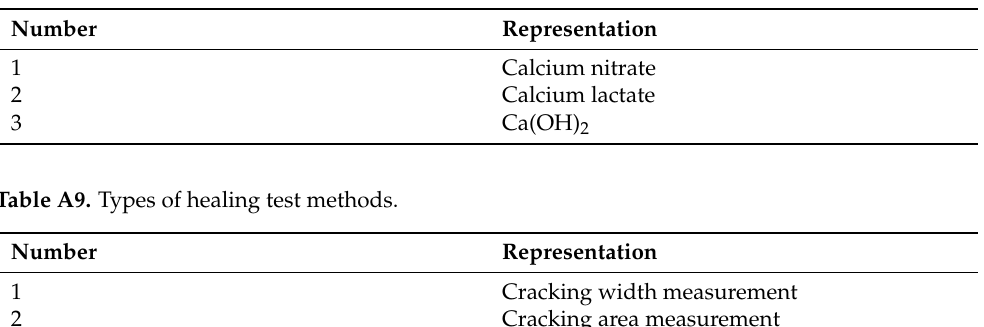
Table A8. Types of calcium ion sources.